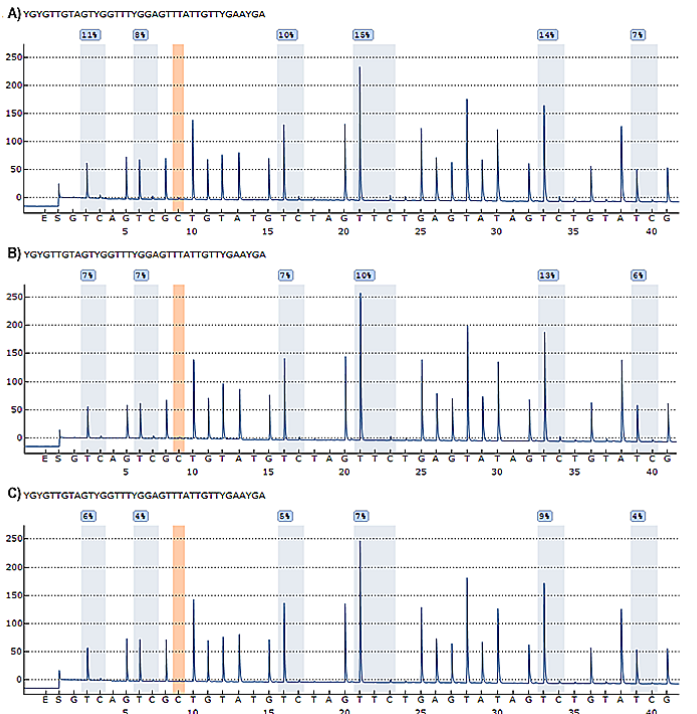
Figure 2. Pyrograms resulting from pyrosequencing process. ( A ) Pyrogram of patient with ASD; ( B ) Pyrogram of a patient with VSD; ( C ) Pyrogram of a control individual. In each pyrogram, the evaluated CpG sites are identified with the letter “Y”. The X-axis describes the order of dispensing during the pyrosequencing process, starting with the enzyme and the substrate, followed by the corresponding nucleotides; the Y-axis represents the relative light intensity corresponding to biolu- minescence. The height of each peak in the CpG sites is proportional to the number of nucleotides incorporated in the analysed sequence. The blue shaded areas represent the CpG sites with their corresponding percentages of methylation; the presence of an orange shaded area indicates a control bisulfite dispensing, representing a suitable bisulfite conversion